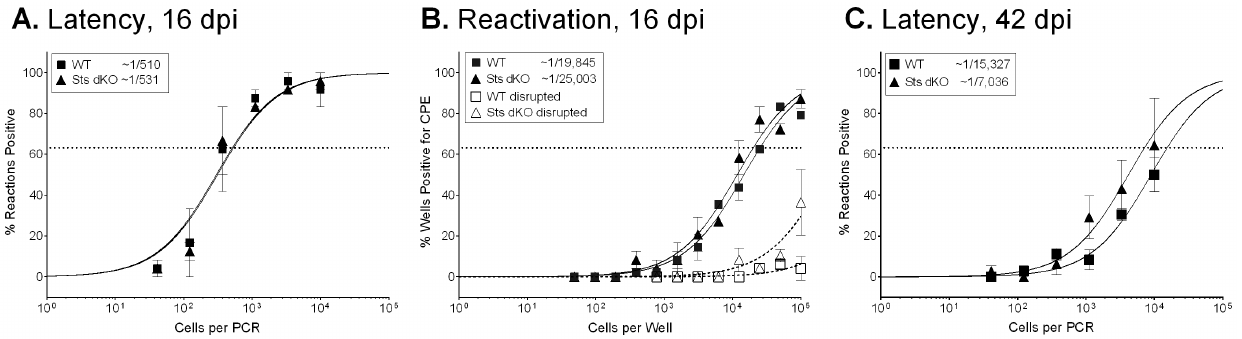
Figure 4. Viral latency and reactivation from latency are unchanged in Sts dKO animals. Sts dKO and C57BL/6 WT mice were infected with 1000 PFU of MHV68 by the intranasal route and single cell suspensions of the spleens were prepared at 16 dpi. (A) Frequency of splenocytes harboring viral genomes determined by limiting dilution nested PCR assay. (B) Frequency of splenocytes reactivting virus determined by a limiting dilution ex vivo reactivation assay. (C) Frequency of splenocytes harboring viral genomes at 45-57. For all limiting-dilution assays, curve fit lines were derived from nonlinear regression analysis, and symbols represent the mean percentage of wells positive for virus (viral DNA or CPE) 6 the standard error of the mean. The dotted line represents 63.2%, from which the frequency of viral genome-positive cells or the frequency of cells reactivating virus was calculated based on the Poisson distribution. Graphs represent 3 independent experiments of 3–4 mice.